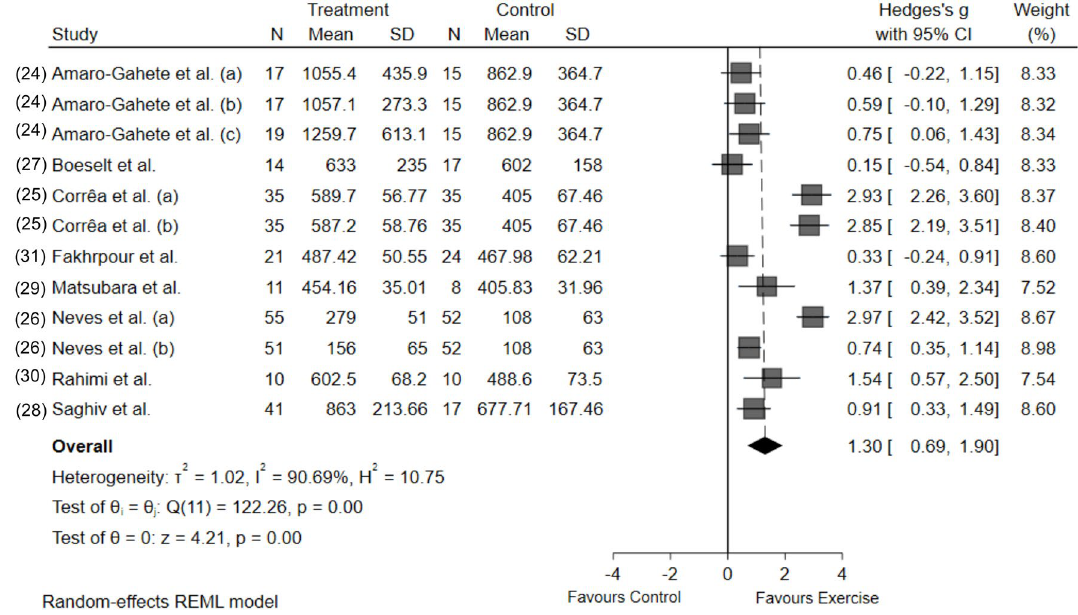
Figure 1. Forest plot of the results from a random-effects meta-analysis shown as Hedges’ g with 95% CIs on Klotho concentrations. For each study, the square represents the Hedges’ g of the intervention effect with the horizontal line intersecting it as the lower and upper limits of the 95% CI. The rhombi represent the total